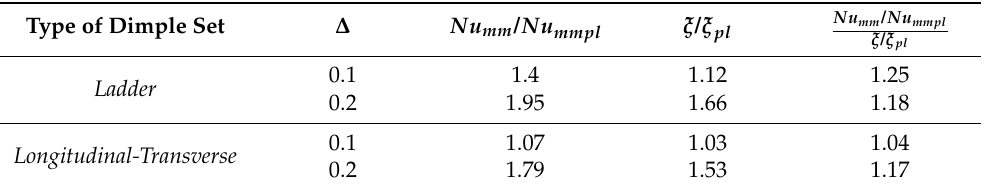
Table 6. Comparison of heat transfer, hydraulic losses, and thermal-hydraulic efficiency for channels with a different arrangement of dimples on the bottom